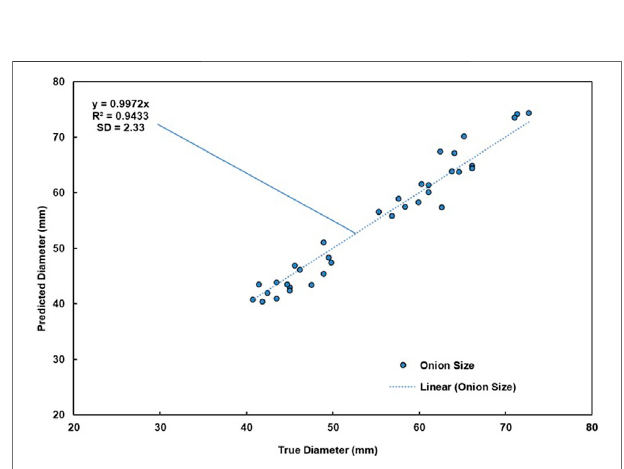
FIGURE 5 | Size calibration